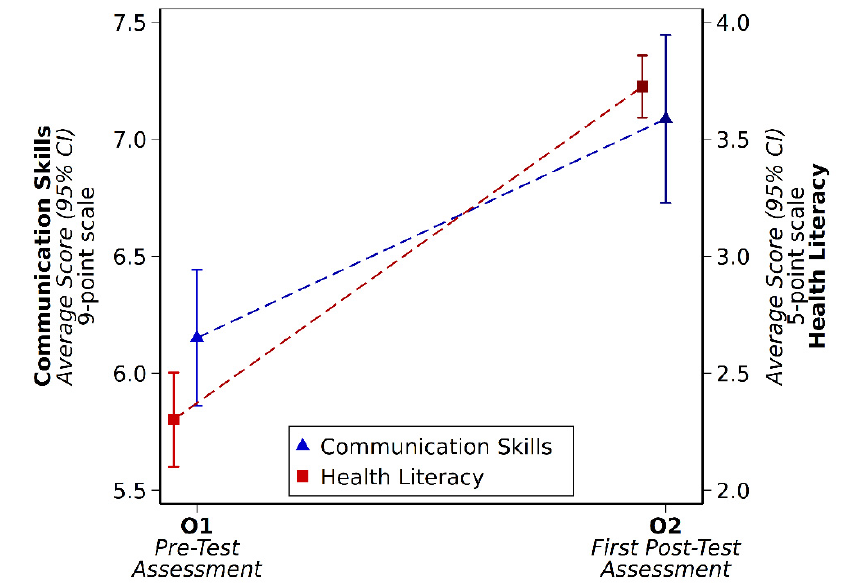
Figure 2. Change in Communication Skills and Health Literacy Skills.